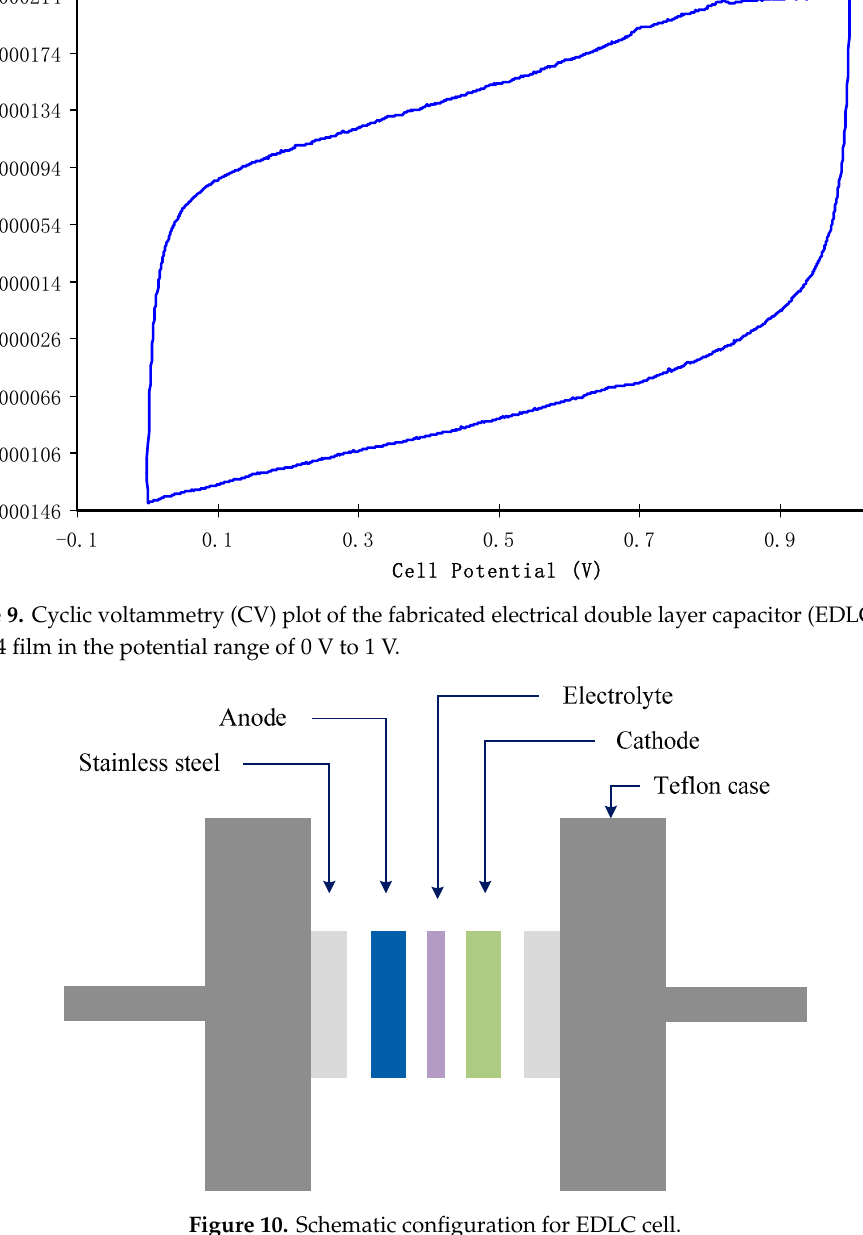
Figure 10. Schematic configuration for EDLC cell.